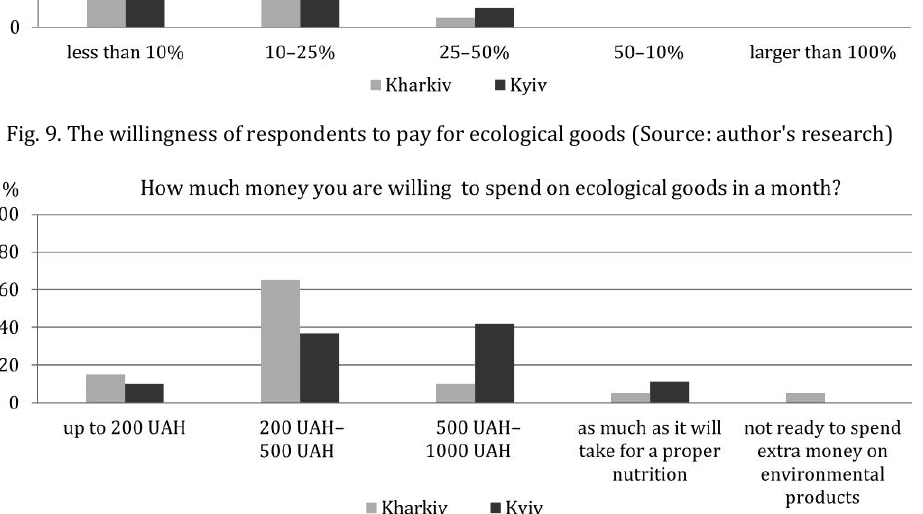
Fig. 10. Willingness of respondents to spend additional funds on ecological goods (Source: author's